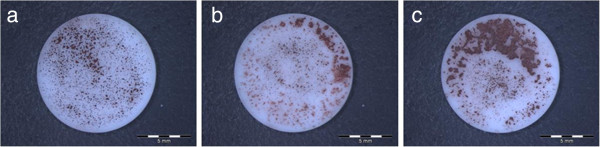
Anti-cytokeratin detected cells after 1 (a), 7 (b), 14 (c) days on ZrO2.